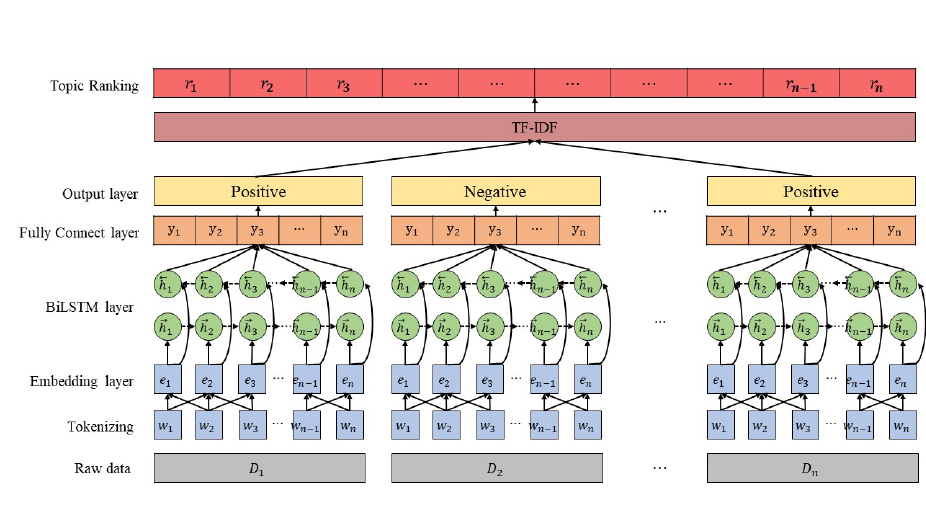
Figure 1. Model architecture of our proposed deep-learning-based ranking algorithm, WBiLSTM-TF-IDF. WBiLSTM -TF-IDF filters out news articles and tweets not related to disease